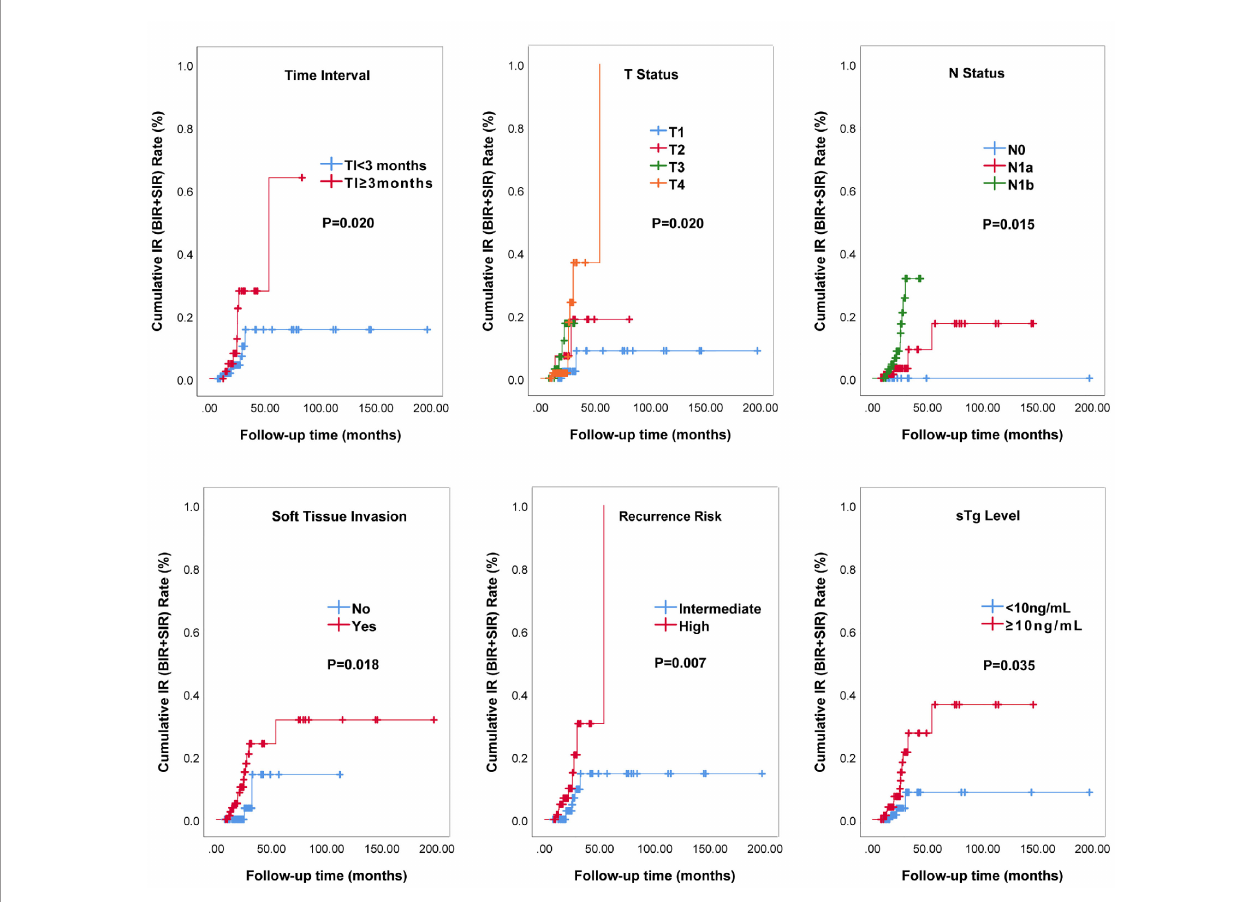
FIGURE 2 | IR curves of intermediate ‐ to high ‐ risk DTC patients receiving RAT analyzed by Kaplan-Meier